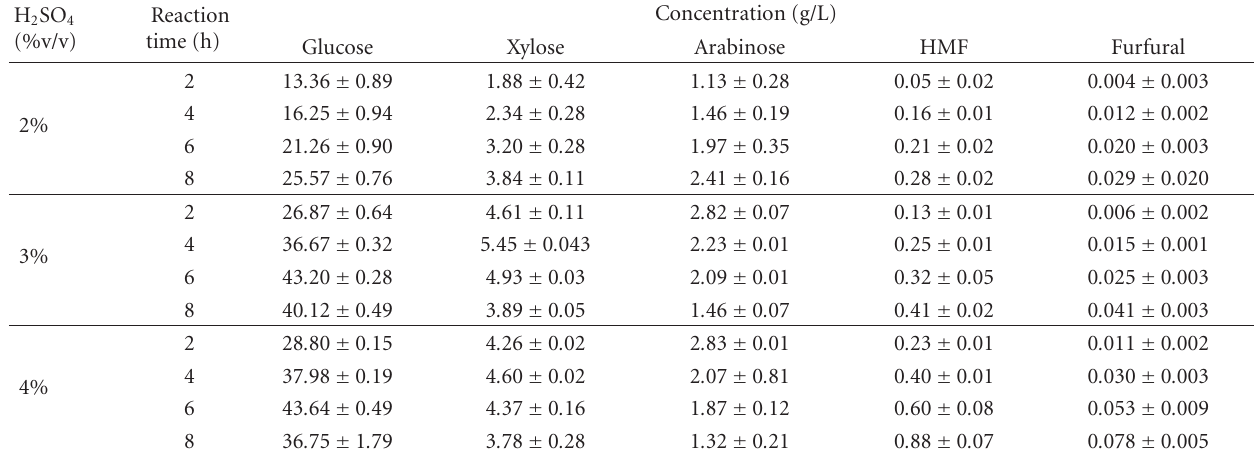
Table 1: Composition of DRBH with di ff erent reaction time and H 2 SO 4 concentration at 90 ◦ C. H 2 SO 4